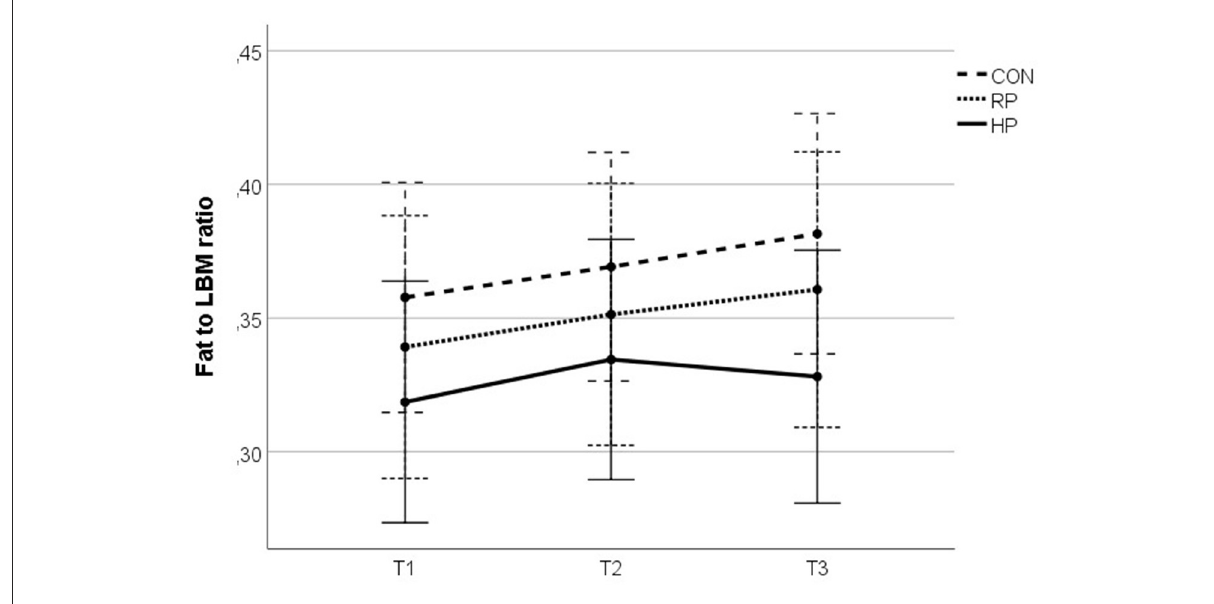
FIGURE3 Fat to lean mass ratio over the study duration.